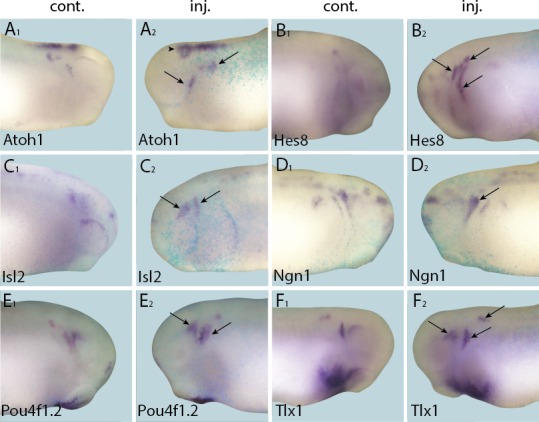
Up-regulation of target gene expression domains after overexpression of Six1.Tail bud stage embryos (A–F) after unilateral injection of Six1-GR and DEX induction at neural plate stage (16–18). In each case, lacZ was co-injected as a lineage tracer and panels A1–F1 show the control (un-injected) side and A2–F2 show the injected side. Arrows and arrowheads mark expansions in marker gene expression in placodal and non-placodal derivatives, respectively.